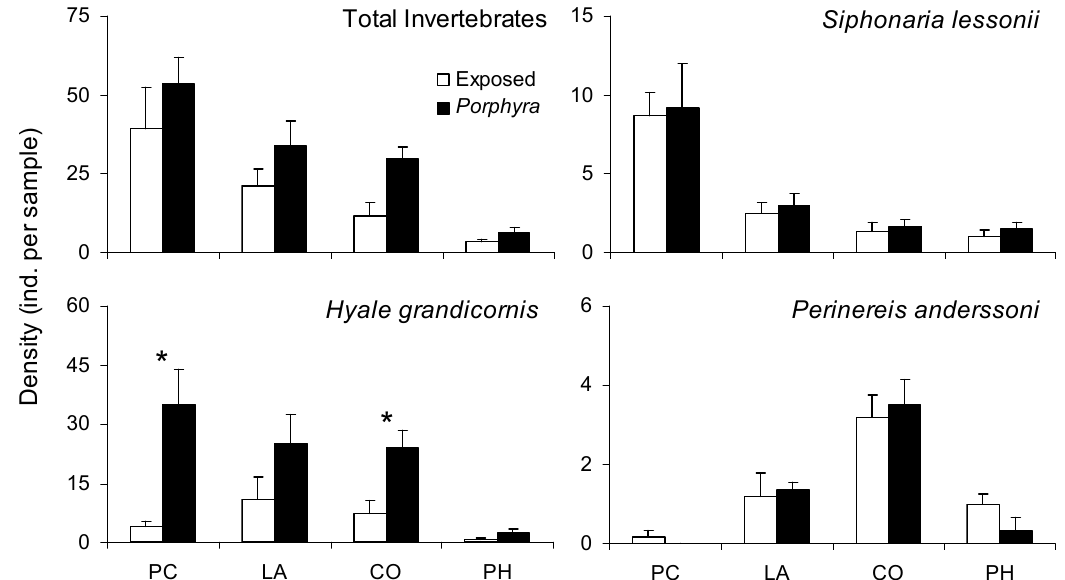
Figure 6. Mean (SE) total invertebrate density and densities of common species (i.e., species present at all sites at mean overall densities in excess of 1 individual per sample) in Porphyra -covered patches and exposed mussel bed areas. Samplings were conducted during February–March when Porphyra cover becomes relatively low (<30% cover) and patchy, and at three sites/dates: Punta Cantera/2016 (PC), Los Acantilados/2018 (LA), Copacabana/2018 (CO), and Punta Hermengo/2016. Asterisks indicate significant different between treatments at a site/date.